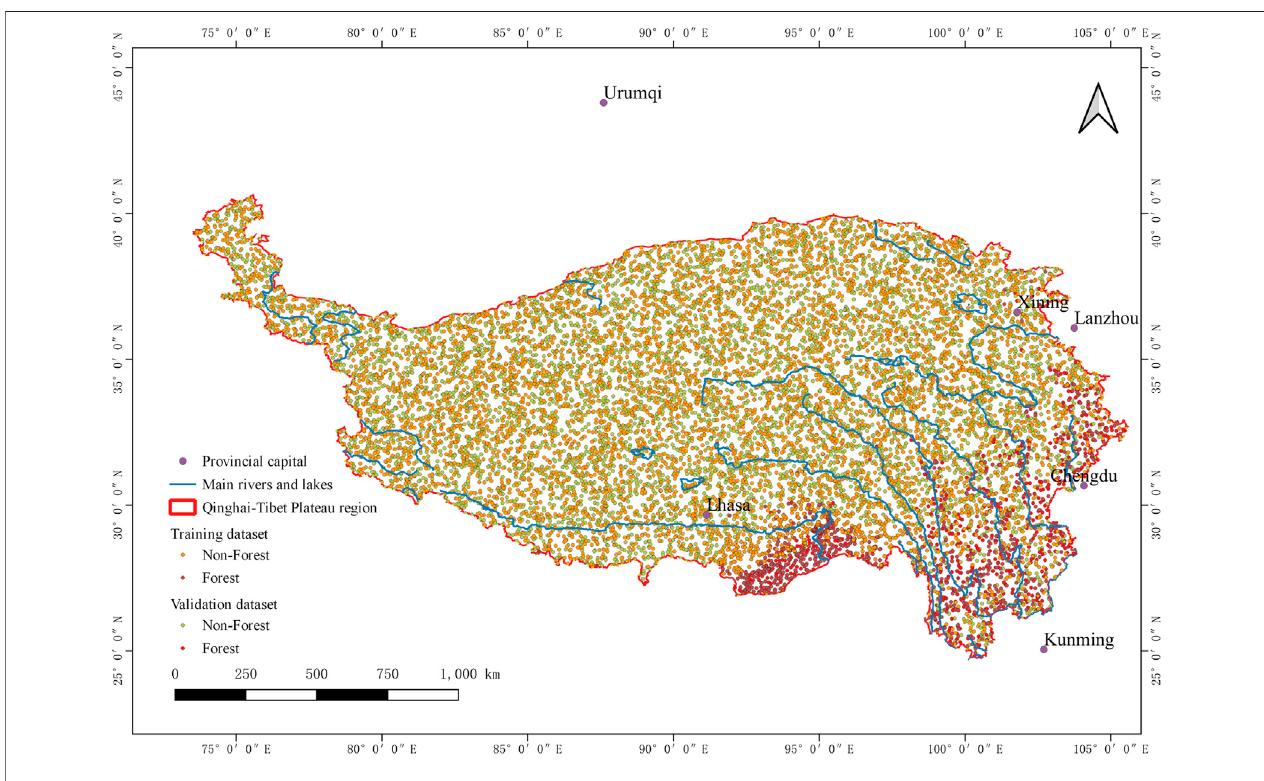
FIGURE 5 | Location of samples in the QTP.